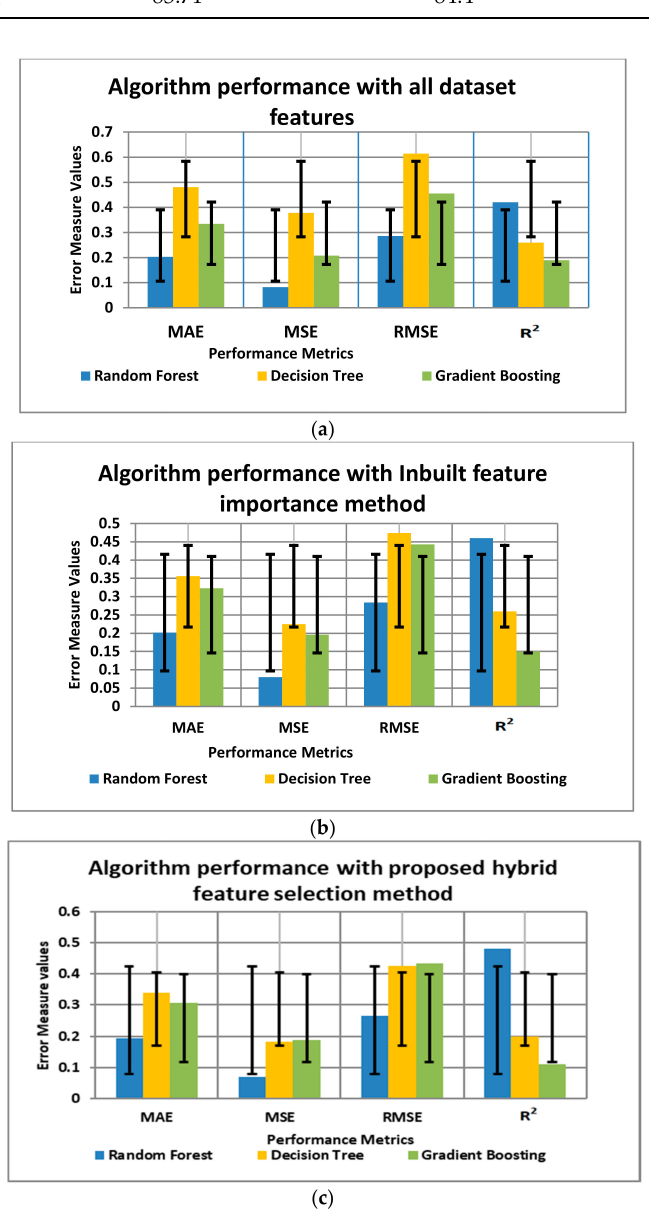
Figure 4. Performance metric results of the machine learning models with ( a ) all dataset features, ( b ) selective features through algorithm in-built feature importance method, ( c ) features obtained through the proposed hybrid feature selection